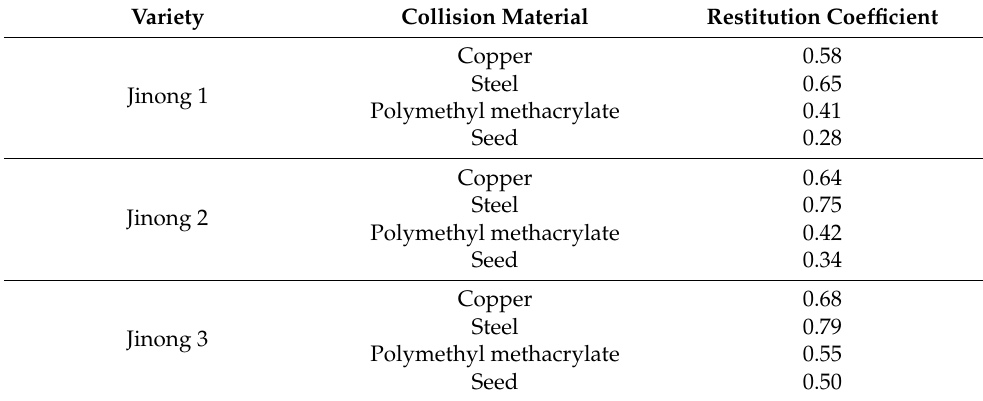
Table 4. Restitution coefficient of different varieties of Cyperus esculentus seeds.